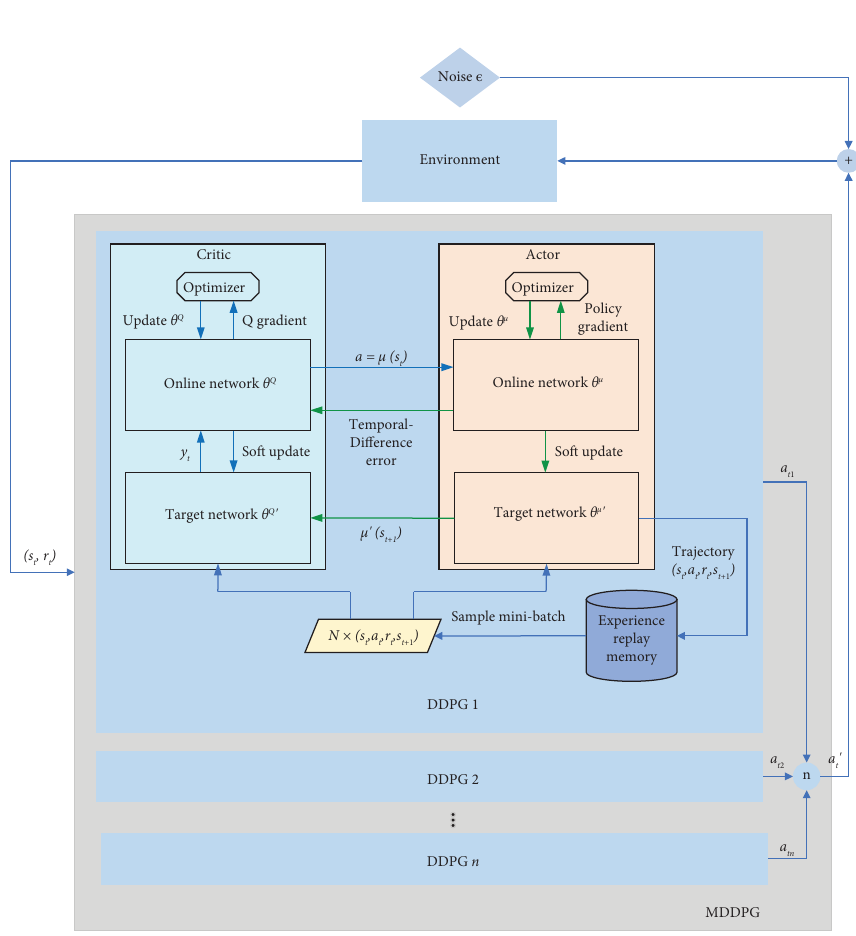
Figure 10: Structure of